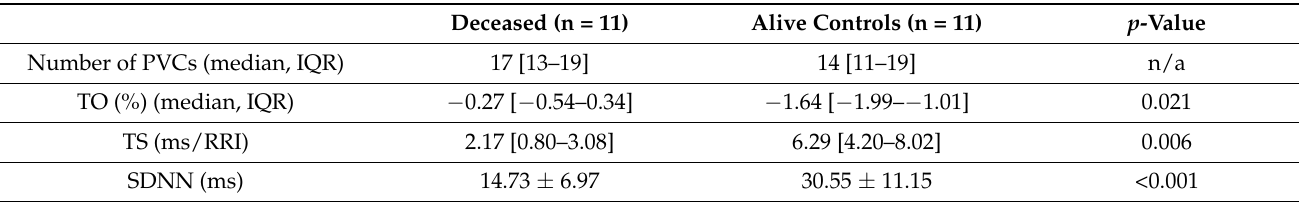
Table 2. Heart rate turbulence and time-domain heart rate variability analysis.